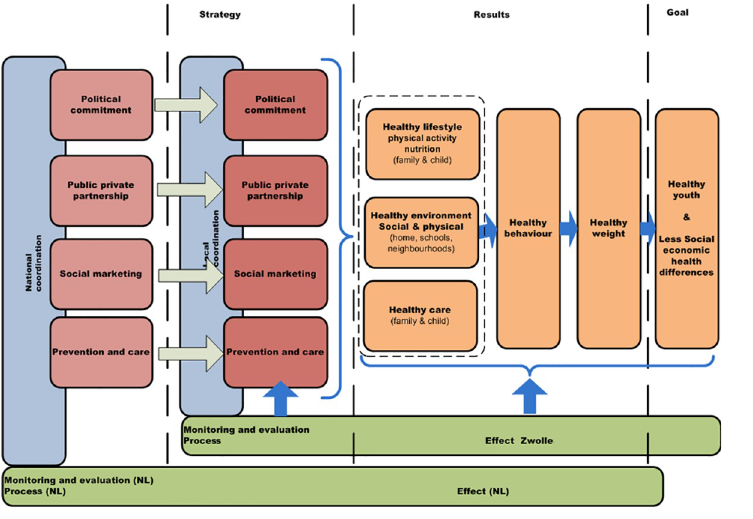
Fig 1. Logic model of the Zwolle Healthy City